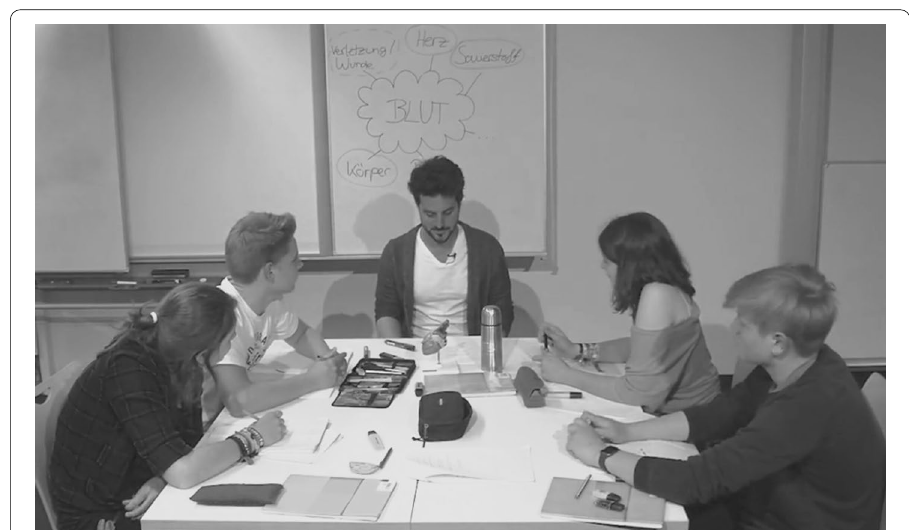
Fig. 2 Screenshot taken from one of the video examples (Brainstorming